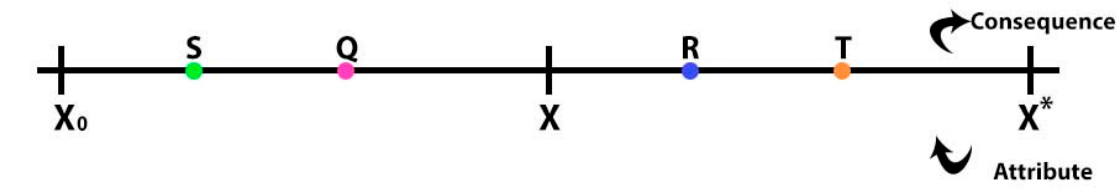
Figure 9. Utilitarian transformation of attributes to consequences.